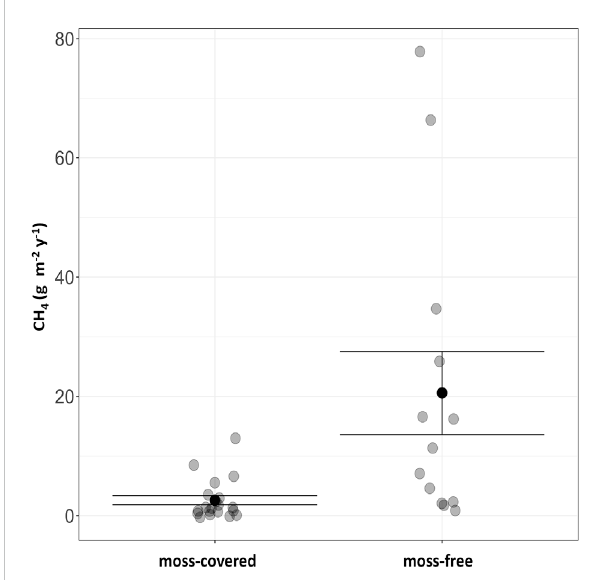
FIGURE 2 CH 4 emission factors in the 2-type classi fi cation scheme of ditches of boreal forestry-drained peatlands. Shown are average ± SE (in black) calculated from the replicate observations (in grey). The difference between the groups is statistically signi fi cant ( t -test; t (31) = − 4.0336, p < 0.001).